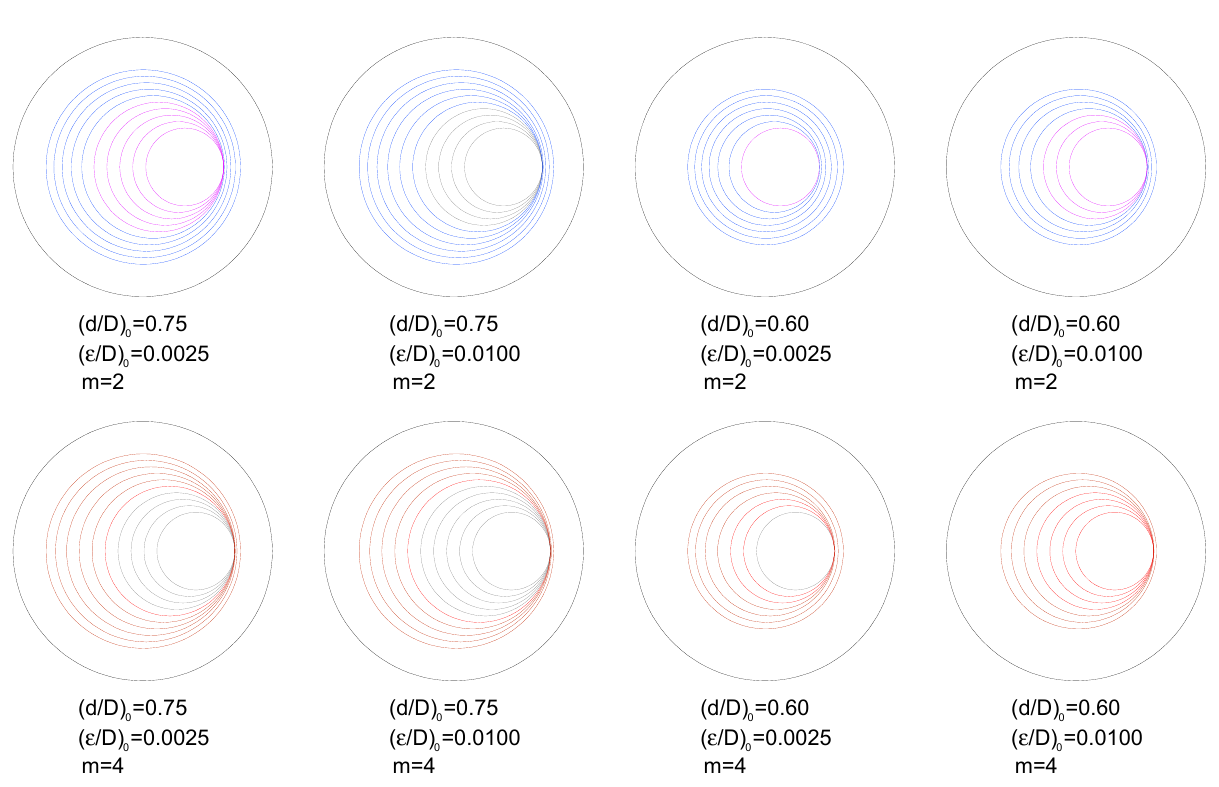
Figure 8. Crack fronts for imposed axial displacement ; m = 2: no contact in blue, partial contact in pink, and full contact in grey; m = 4: no contact in brown, partial contact in red, and full contact in grey.